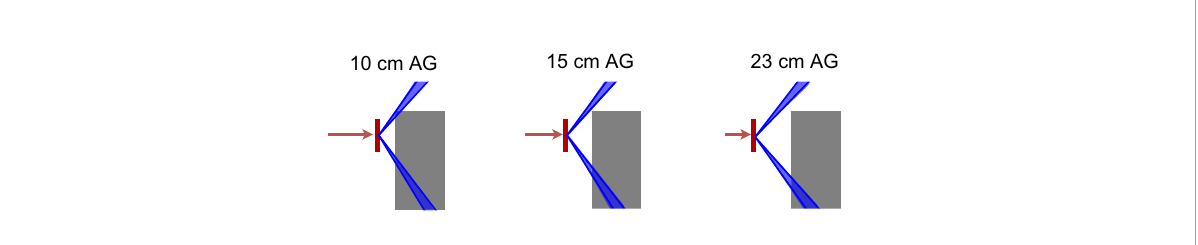
FIGURE 11 The blue cones indicates the path from the centre of the range shifter (red) to the borders of the detectors at positions A (top) and C (bottom). When the air gap is small, a particle that travels in a straight line needs to travel through more phantom material (grey) than when the air gap is large. This can be one reason to the air gap dependency that is seen for position C in Figure